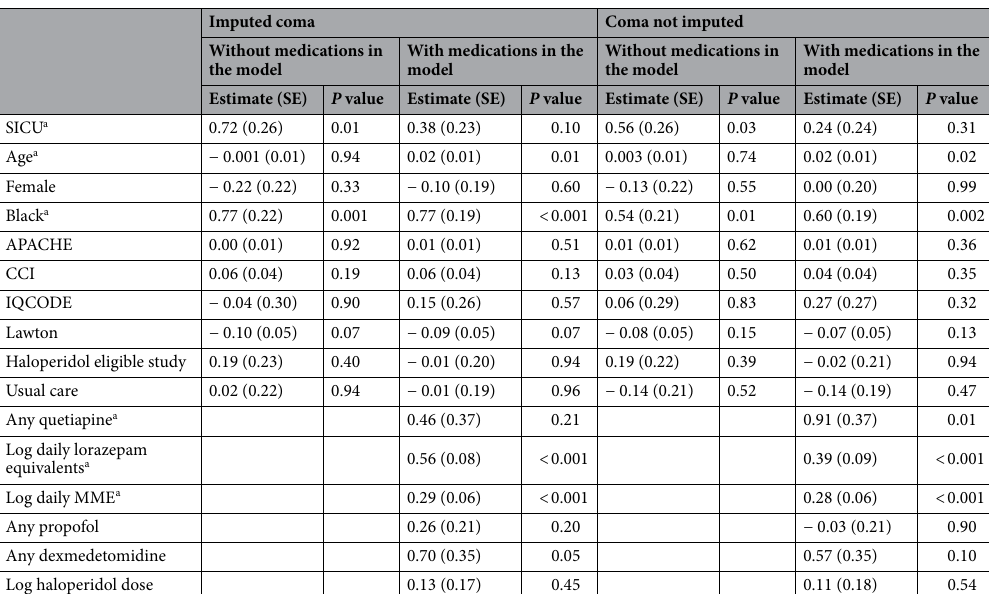
Table 4. Regression results for CAM-ICU-7. This table presents the linear regression analysis for delirium severity taking into account ICU type as well as other variables including medications. Delirium severity was determined by the mean of the CAM-ICU-7 scores in the first 7 days after enrollment. SE standard error, APACHE II acute physiology and chronic health evaluation is a score which measures severity of illness, IADL instrumental activities of daily living (Lawton), ADL activities of daily living (Katz), SICU surgical intensive care unit, MICU medical intensive care unit, CCI Charlson Comorbidity Index, IQCODE informant questionnaire on cognitive decline in the elderly, MME morphine milligram equivalent. a Significant differences in regression